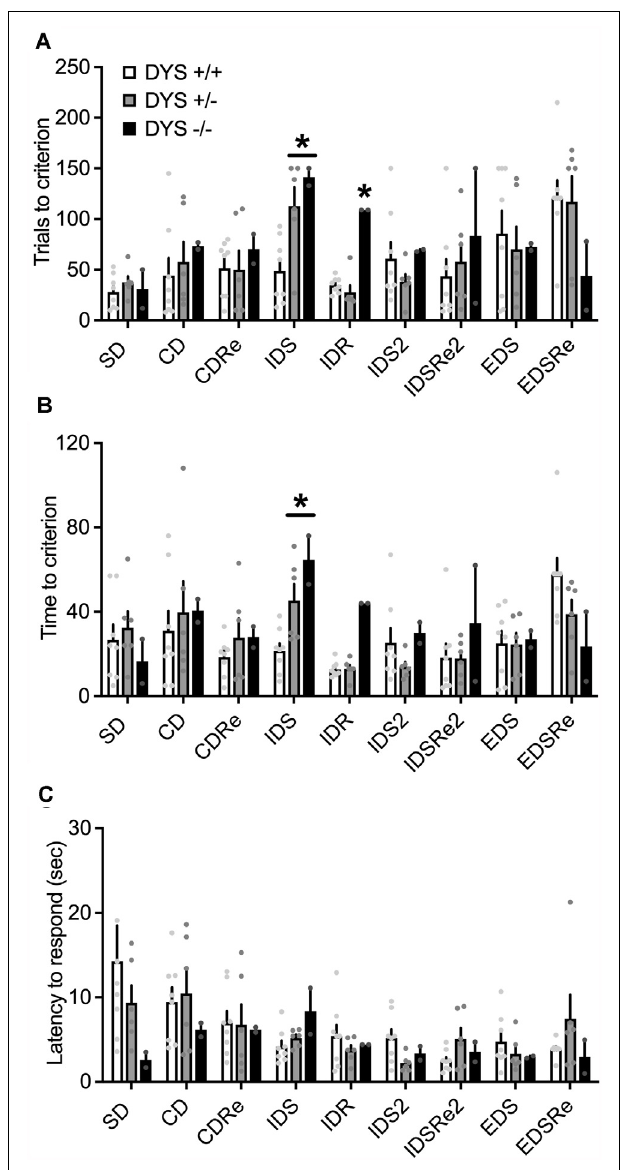
FIGURE 7 | (A) Number of trials and (B) time required by DYS + / + , DYS + / − , and DYS − / − adolescent mice to reach the criterion in the different stages of, ID/ED Operon task. (C) Latency to respond in each stage of the ID/ED Operon task in DYS + / + , DYS + / − , and DYS − / − adolescent mice. * p < 0.05 vs. DYS + / + mice at the same stage. Values represent mean ±